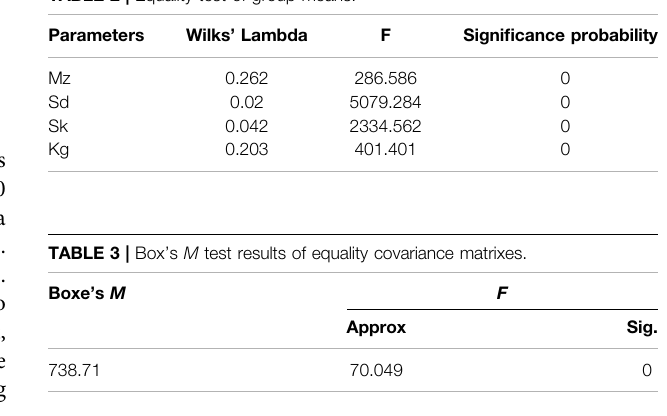
TABLE 2 | Equality test of group means.